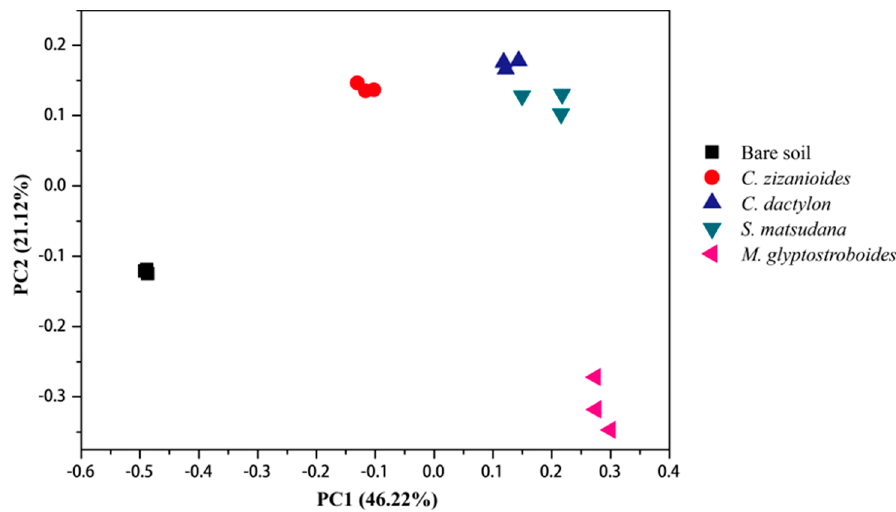
Figure 3. Principal coordinates analysis (PCoA) results of bacterial community diversity.